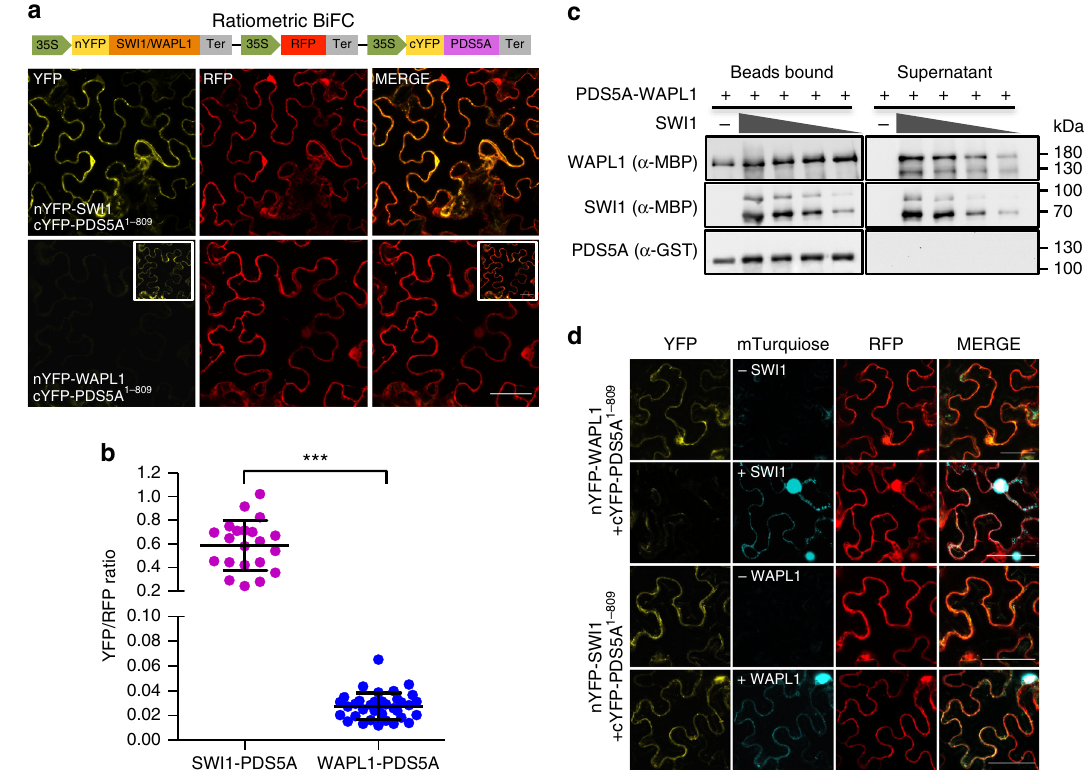
Fig. 4 SWI1 dissociates WAPL1 from PDS5A. a Ratiometric BiFC (rBiFC) assays of PDS5A with SWI1 and WAPL1. The upper panel depicts the ratiometric gene expression cassette, and the below panels show representative images of the assay that were captured with the same settings at a confocal laser scanning microscope. The level of YFP fl uorescence indicates the interaction strength with the RFP fl uorescence used as a reference. The images in the white box represent the same pictures as the ones shown in the respective panel but taken with increased sensitivity revealing an interaction between WAPl1 and PDS5A. Bar: 50 μ m. b Quanti fi cation of the rBiFC assay by calculating the ratio between YFP and RFP signal intensity shown in a . Asterisks indicate signi fi cant difference (Student ’ s t -test, P < 0.001). Error bars represent standard deviations. c SWI1 causes the dissociation of WAPL from PDS5. Anti-GST beads were incubated with or without SWI1 1-300 in the presence or absence of PDS5A 1-809 -WAPL1 heterodimers. PDS5A 1-809 is His-GST tagged. WAPL1 and SWI1 1-300 are His-MBP tagged. Beads bound proteins were separated from the supernatant and analyzed by immunoblotting. Different amounts of SWI1 1-300 were used for the experiment. The empty beads control was shown in Supplementary Fig. 9e. The source data of the uncropped immunoblots are provided in the Source Data fi le. d Co-expression of SWI1-mTurquiose inhibits the interaction of WAPL1 with PDS5A in tobacco leaf cells while the presence of WAPL1-mTurquiose has no obvious impact on the interaction of SWI1 with PDS5A. Bar: 50 μ